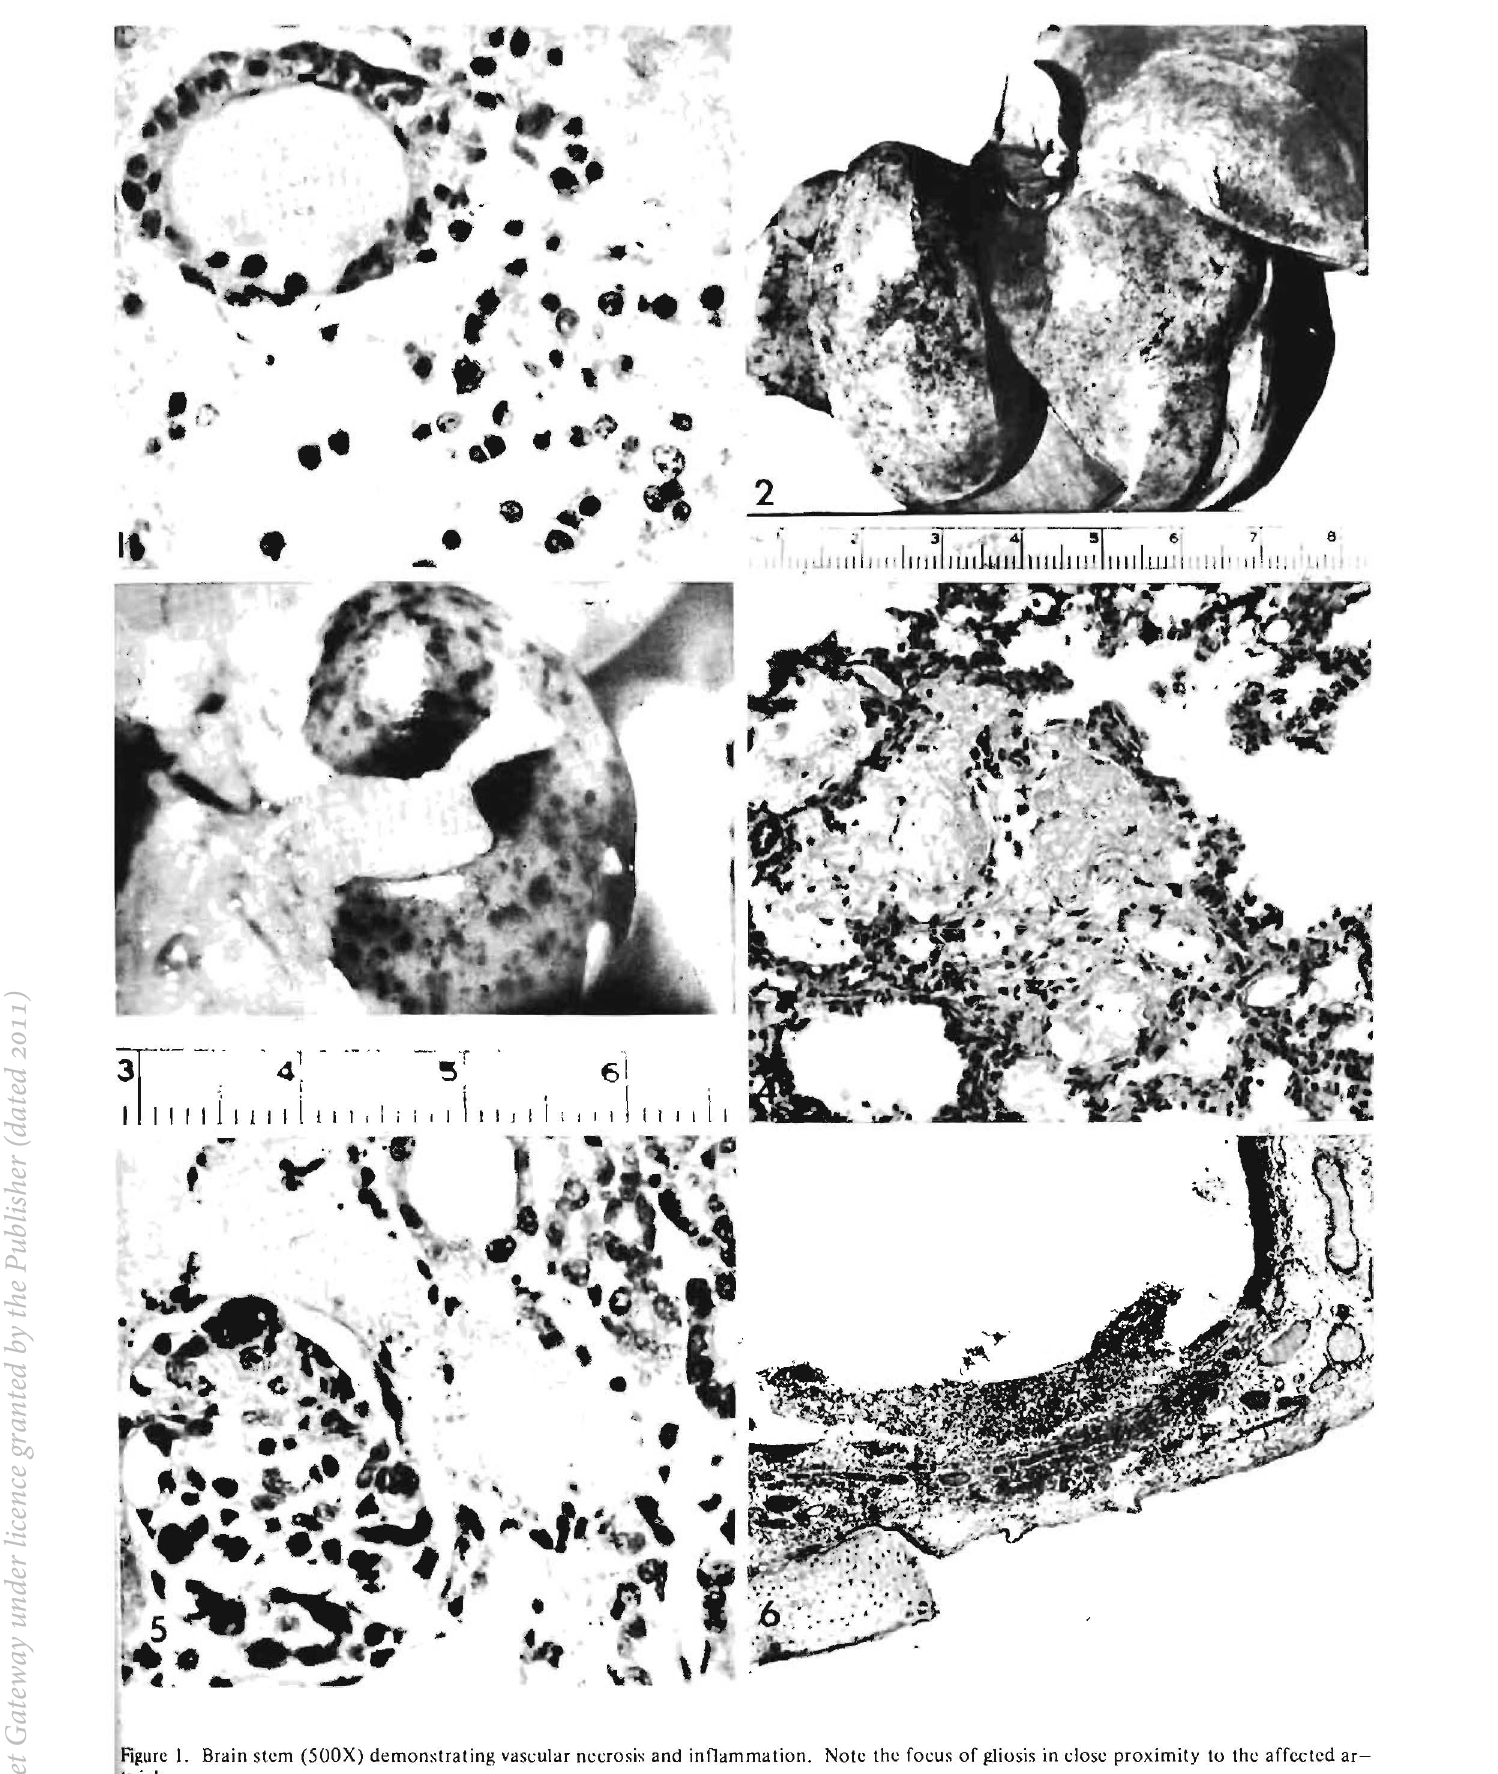
Figure l. Brain stem (500X) demonstrating vascular necrosis and innammation. Note the focus of gliosis in close proximity to the affected ar teriole. figure 2. Gross photograph of liver depicting focal. dissem ina te necrosis and haemorrhage. Figure 3. Gross photopaph of kidney demonstrating the characteristic "bird's egg" appearance or disseminated focnl haemorrhage and necrosi~. figure 4. Photomicrograph of the'lung (200X) demonstrating focal nel'fosis and fibrinous alveolar exudate. Figure 5. Photomicropaph of the kidney (500X) depicting coagulative tubular necrosis. Figure 6. Photomicrograph of nasal pharynx (75X) demonstrating a fibrino-nel'fotir focus which may be indicative of the portal of entry.